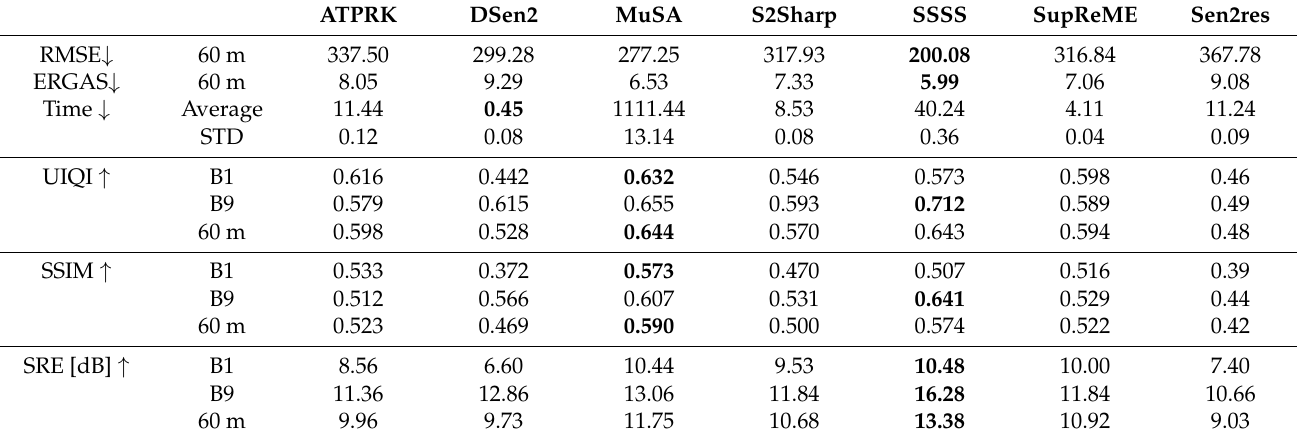
Table 2. Evaluation using reduced scale S2 data: Reduced by 6, super-resolved 360 → 60 m. The best results are given in bold